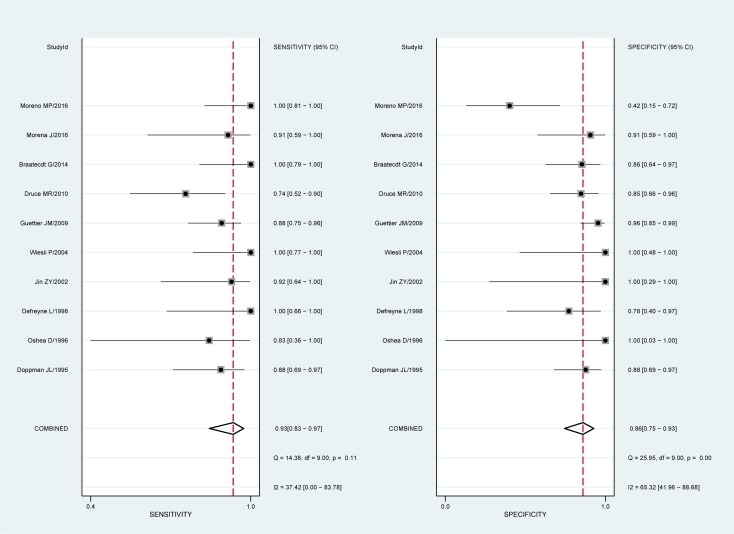
Forest plots for sensitivity and specificity.